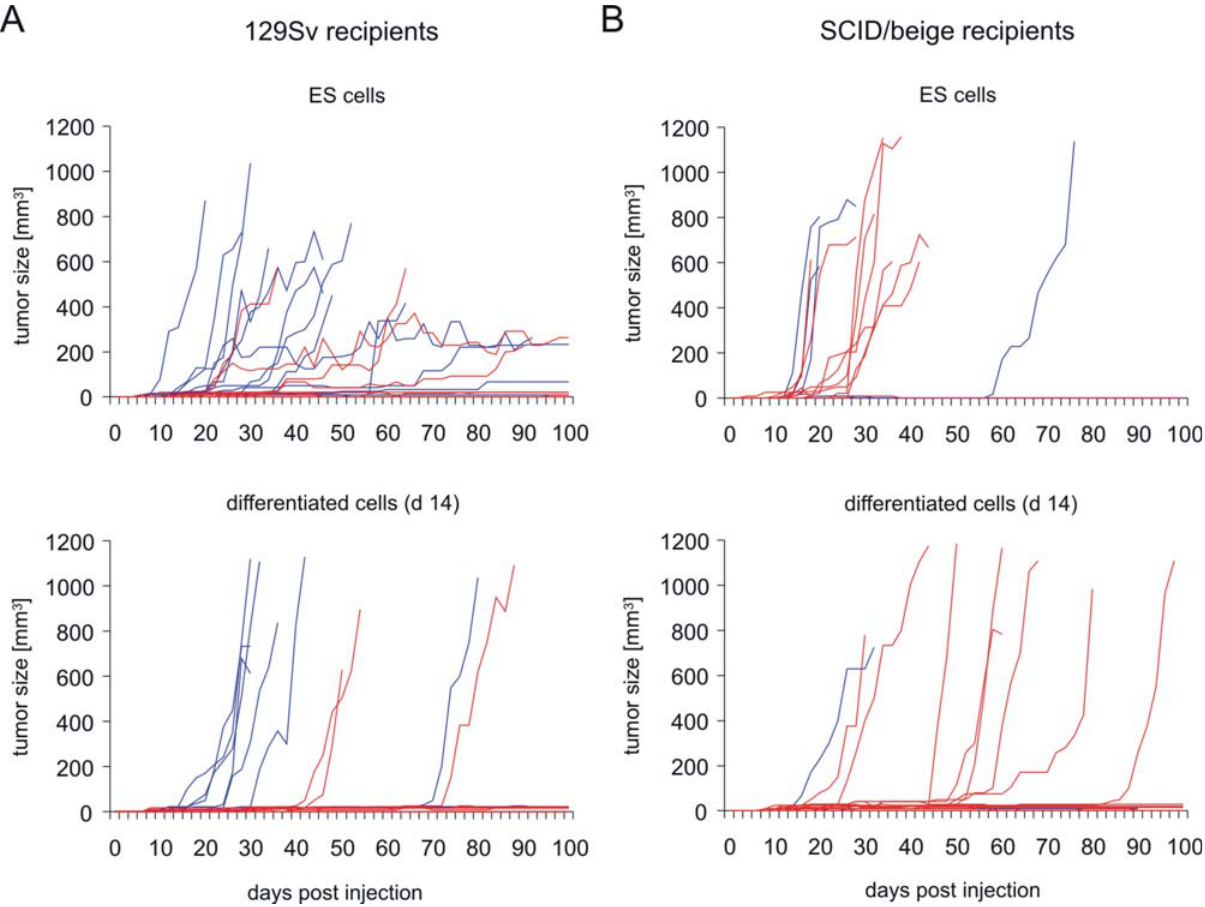
Figure 1. Tumor growth in syngeneic 129Sv and immunodeficient SCID/beige mice after injection of ES cells or invitro differentiated cells. (A) 1 6 10 6 EScells (MPI-II)or in vitro differentiated cells (day14ofdifferentiation culture)wereinjectedsubcutaneously at day 0 intosyngeneic129Sv mice (for the numbers of animals see Table 2). The tumor size was recorded every second day until day 100 using linear calipers. The growth of tumors in individual mice is shown. Tumor growth in female hosts is indicated by red and in male hosts by blue lines. (B) 1 6 10 6 ES cells or in vitro differentiated cells were injected subcutaneously at day 0 into immunodeficient SCID/beige mice which are deficient for T, B, and functional NK cells.